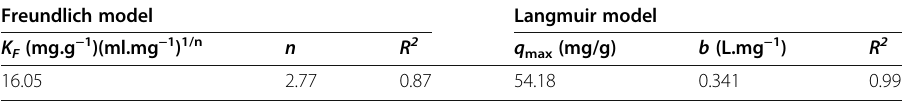
Table 2 Isotherm parameters nickel adsorption by BF slag Freundlich